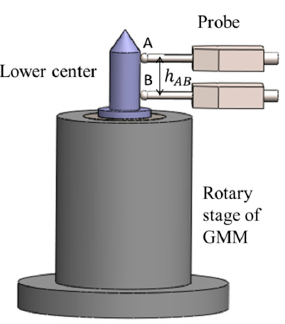
Figure 7. Measurement of run-out of a lower center.